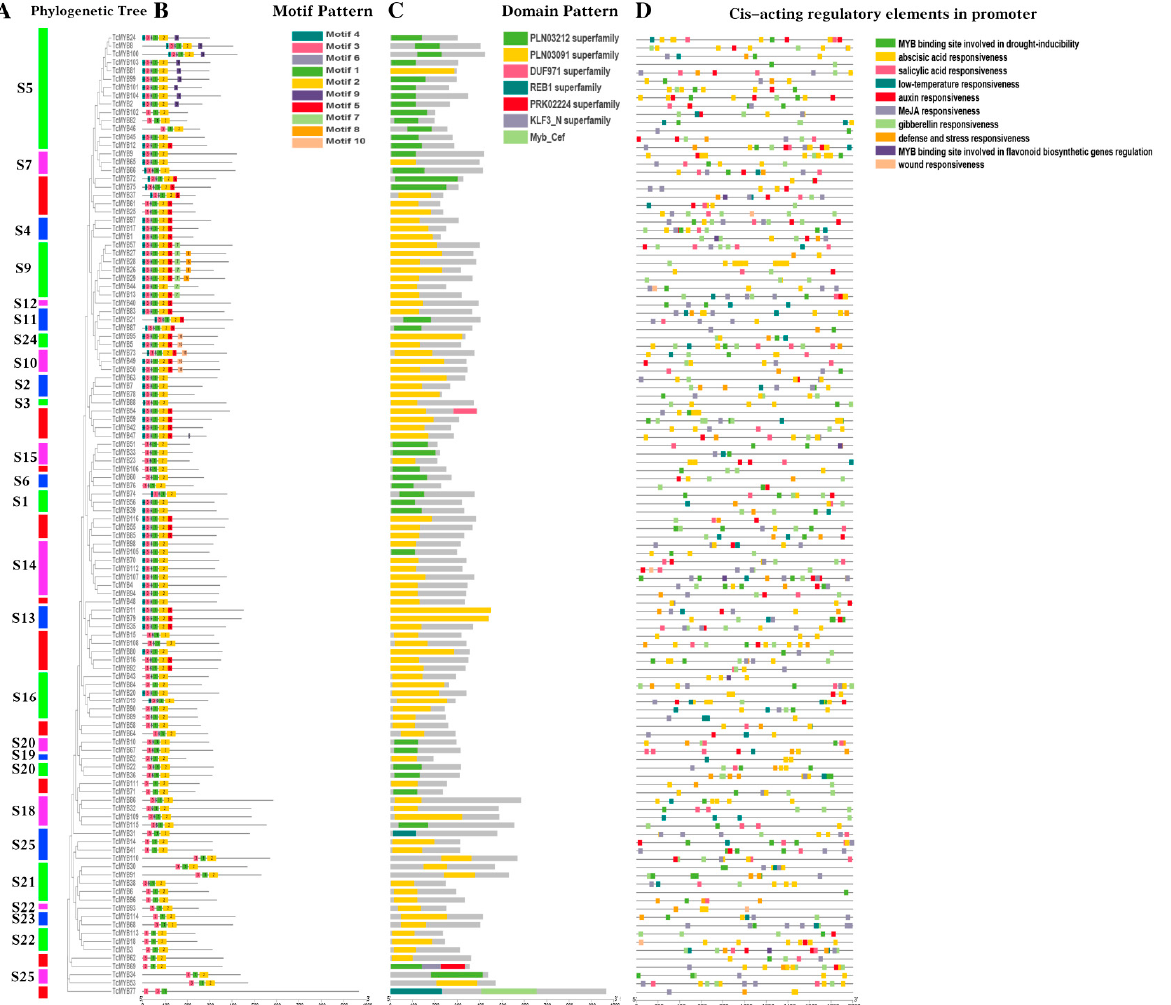
Figure 2. Phylogenetic tree, motifs, domains and cis -acting regulatory element of R2R3-MYB genes from Theobroma cacao . ( A ) The phylogenetic tree of Theobroma cacao R2R3-MYB ( TcMYB ) genes was constructed using MEGA X software. ( B ) The motif compositions of the Theobroma cacao R2R3-MYB proteins. Different colored boxes represent motifs. The detailed sequence for each motif is provided in Supplementary File S2. ( C ) Domain architecture of TcMYB genes. The domains are displayed in different colored boxes. ( D ) The regulatory element of TcMYB gene promoters. Different colored boxes represent regulatory elements.